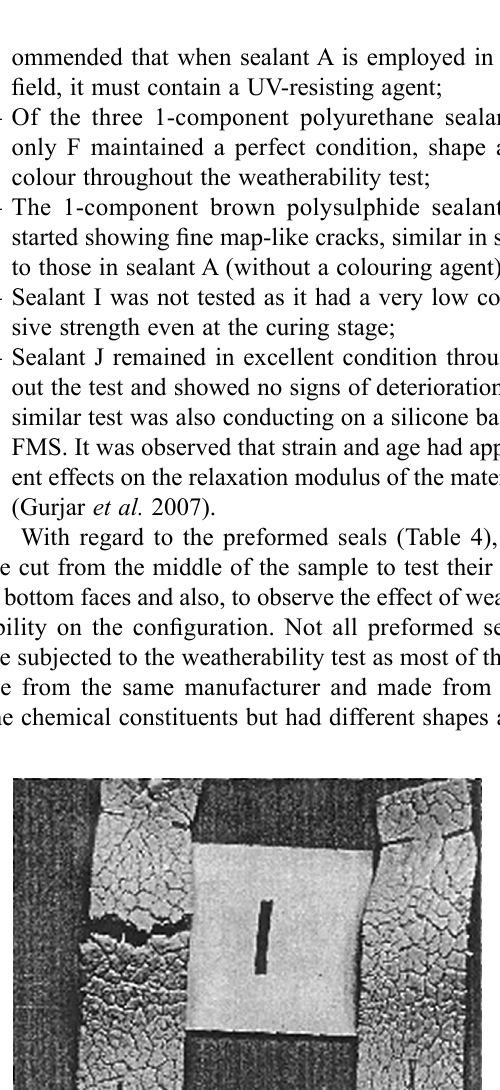
Fig. 5. Load deflection behaviour of preformed seals from –50 °C to +50 °C